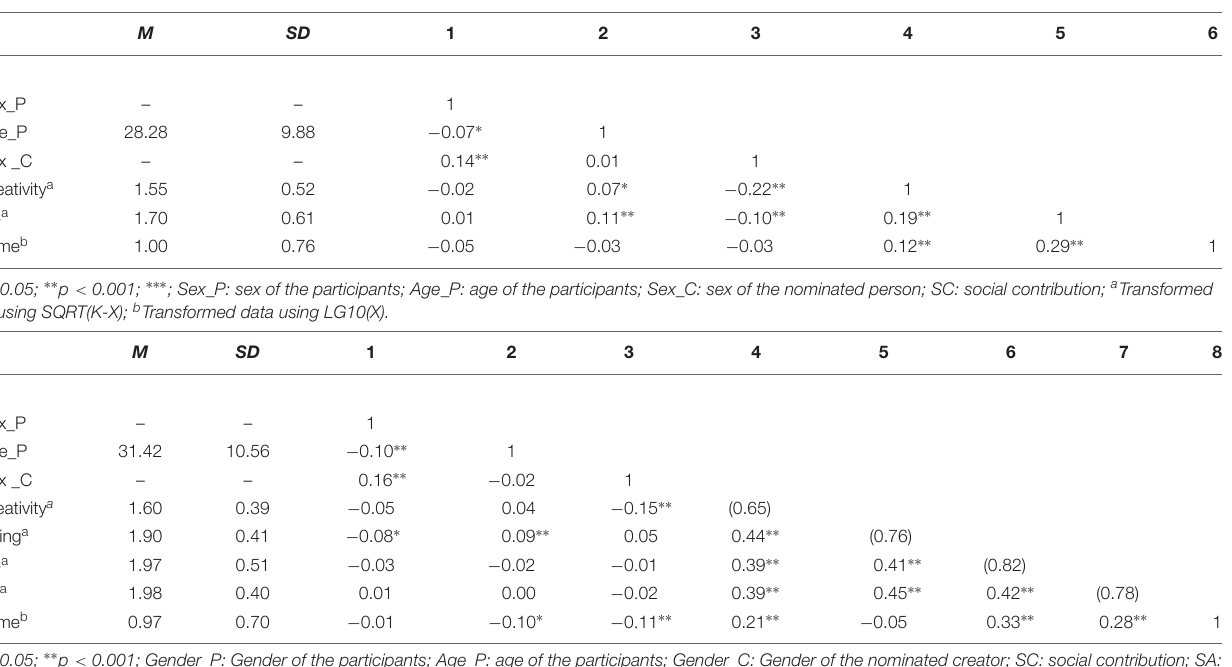
TABLE 3 | Descriptive statistics and correlations between the variables: 2013 and